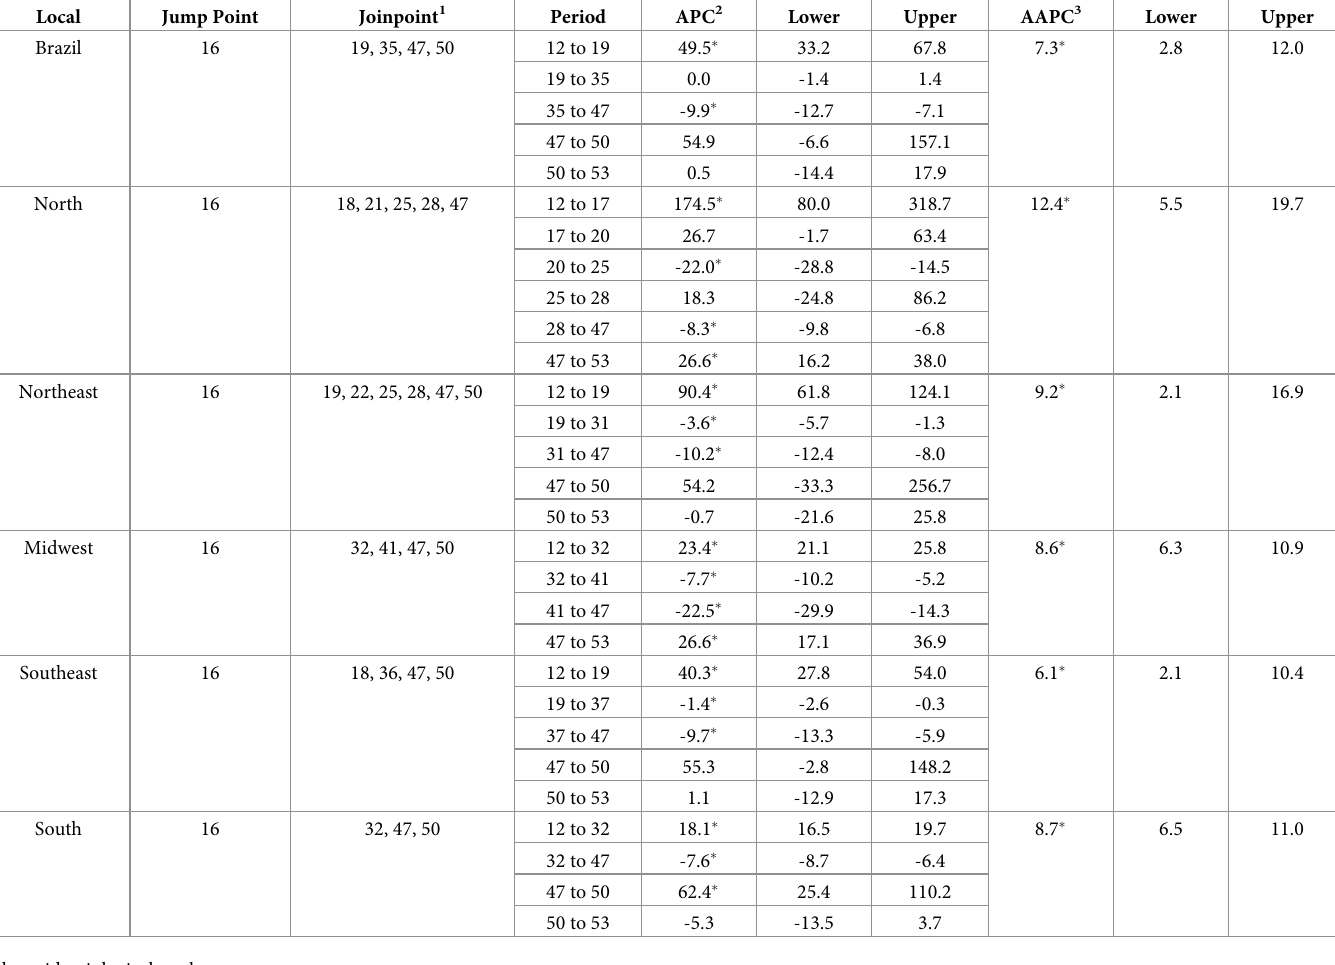
Table 1. Mortality rate due to COVID-19 in Brazil and regions in the period from 12ª to 53ª epidemiological week. Brazil, 2020. Local Jump